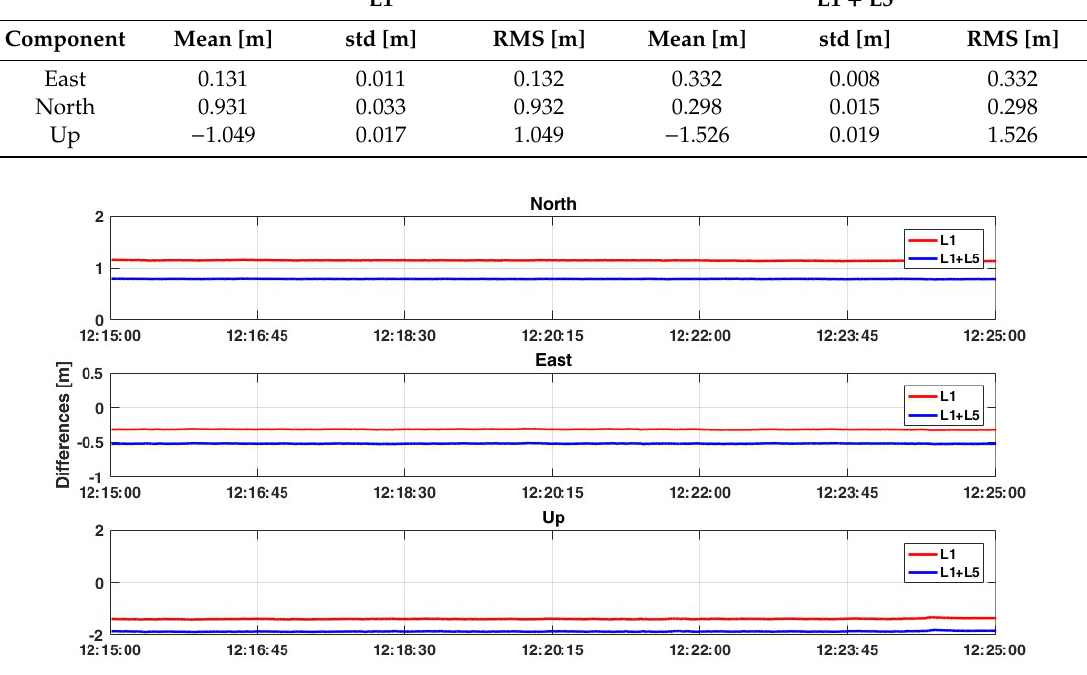
Figure 8. Comparison between L1 and L1 + L5 solutions considering the GPS-only constellation and ratio =30.